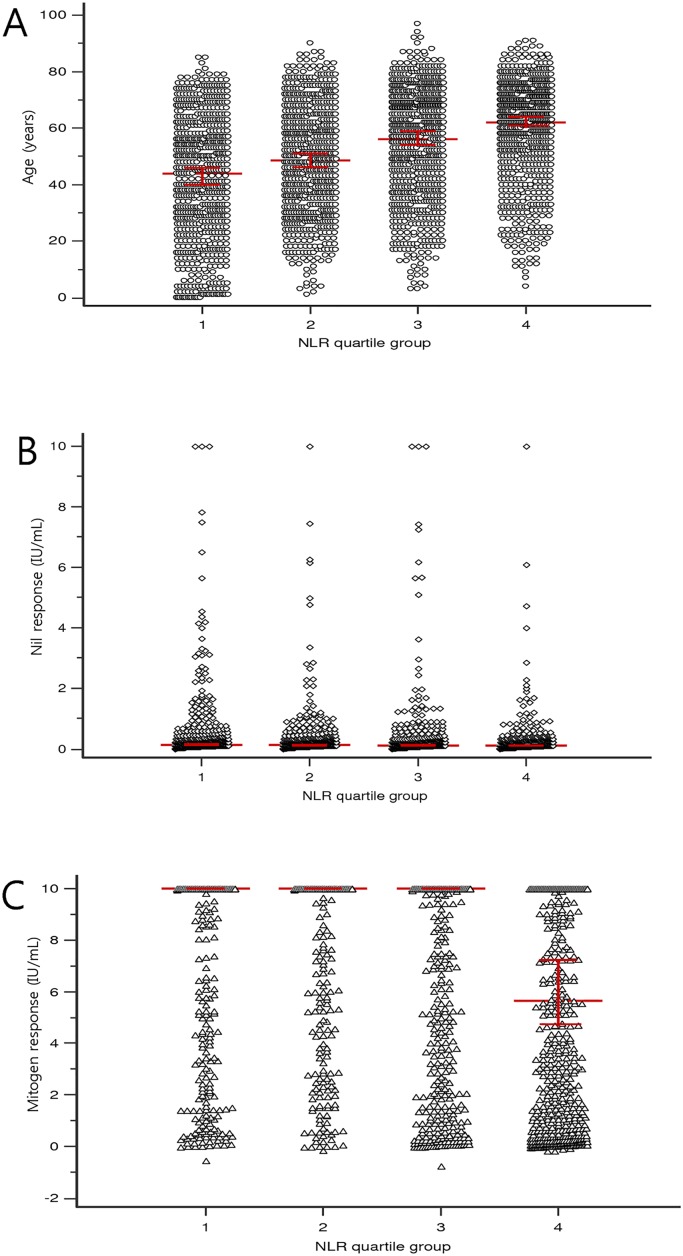
Relationship between variables and neutrophil-to-lymphocyte ratio (NLR) quartile group (n = 2773).(A) Age NLR quartile Q1;≤1.7 Q2;1.71–2.84 Q3;2.85–5.17 Q4;≥5.18. The red lines indicate the median and 95% confidence interval. (B) Nil response according to NLR quartile group in QuantiFERON-TB Gold In-Tube (QFT-GIT) assay. Nil response indicates the concentration of interferon-γ in plasma from unstimulated blood. (C) Mitogen response according to NLR quartile group in QFT-GIT assay. Mitogen response is calculated interferon-γ in plasma from phytohemagglutinin stimulated minus nil.